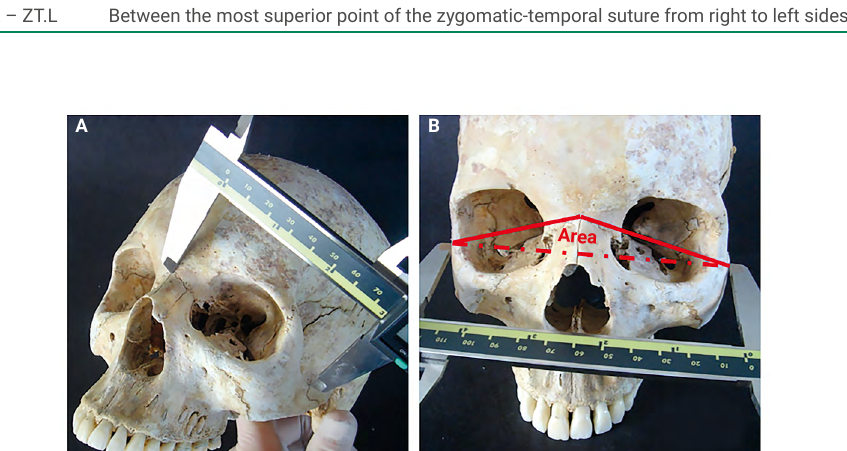
Figure 1. Measure taken from nasion to point ZT.L (A); and graphic representation of the triangle formed by the three points